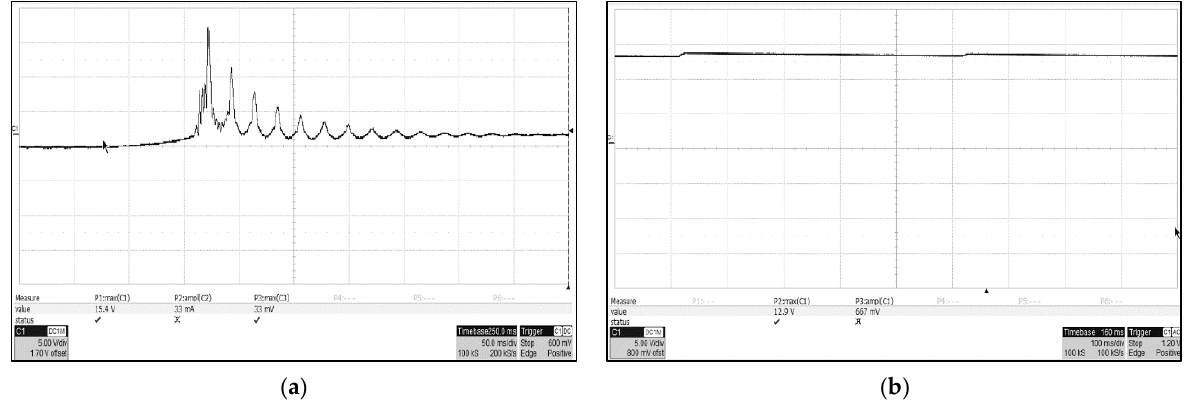
Figure 10. Voltage signal under excitation by mechanical force, as captured from an oscilloscope: ( a ) rectified voltage signal; ( b ) voltage signal boosted by boost converter.